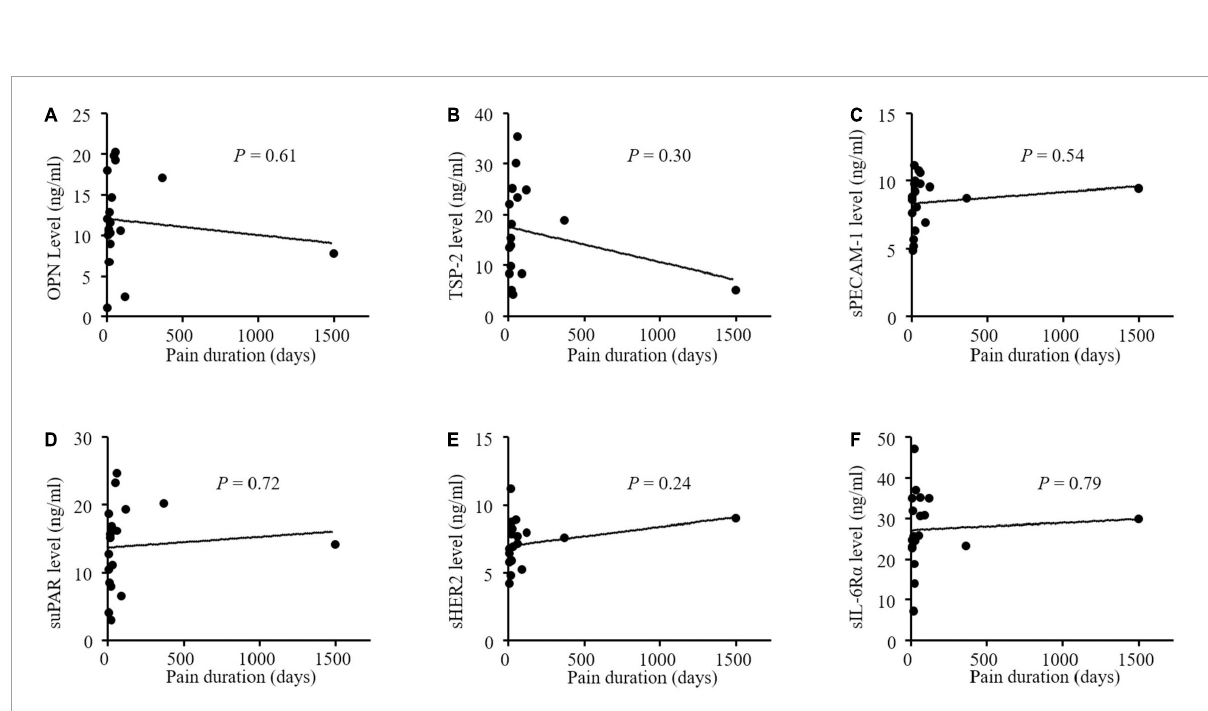
FIGURE4 (A-F) No correlations between concentrations of angiogenic factors and pain duration in patients with postherpetic neuralgia (PHN). OPN indicates osteopontin; TSP-2, thrombospondin-2; sPECAM-1, soluble platelet endothelial cell adhesion molecule-1; suPAR, soluble urokinase-type plasminogen activator receptor; s ErbB2, soluble human epidermal growth factor receptor 2; sIL-6R α , soluble interleukin-6 receptor α ; VAS, visual analog